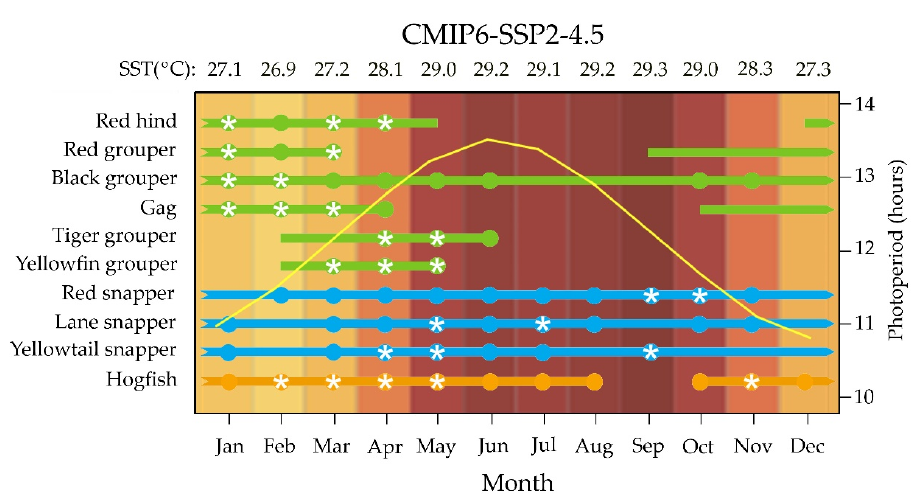
Figure 1. Species’ natural female reproductive cycle of studied grouper (green bars) [36–38,40,41], snapper (blue bars) [39,42,43], and wrasse (orange bar) [44] from the Campeche Bank. Colors indicate monthly mean sea surface temperatures (SST) predicted by the Intergovernmental Panel on Climate Change, for the more-plausible CMIP6 SSP2-4.5 scenario projected for 2022 [46–48]. For each species, solid bars represent reproductive season reported as the months that include spawning-capable females; solid circles represent spawning season reported as the months that include actively spawning females, and white stars represent peak spawning reported as the months that include more than 50% of females in actively spawning sub phase (for reproductive phase terminology see [49]). Yellow curve indicates monthly photoperiod length (Time and Date AS 1995–2022. Available online: http://www.timeanddate.com/sun/mexico/merida, accessed on 1 March 2022). Table 2. Spawning temperature ranges observed in captivity ( 1 ) and in their natural habitat ( 2 ; bottom temperature) for grouper, snapper, and wrasse species analyzed in the present